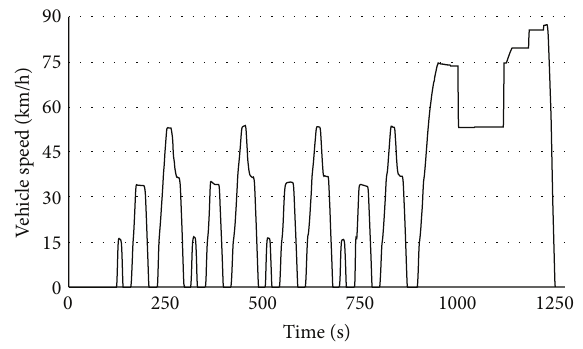
Figure 1: Driving cycle of data